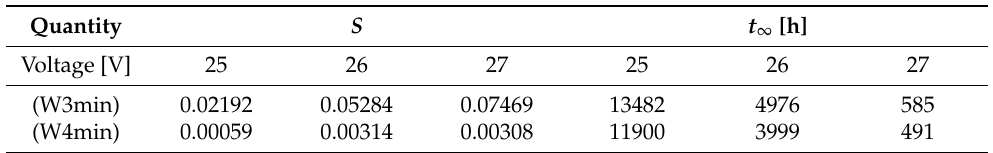
Table 5. Comparison of the sums of least squares S and the values of the t ∞ parameter in the Weibull plots of the times to failure of a power transistor at the voltages 27 V, 26 V, and 25 V [17] using the (W3min) and (W4min)